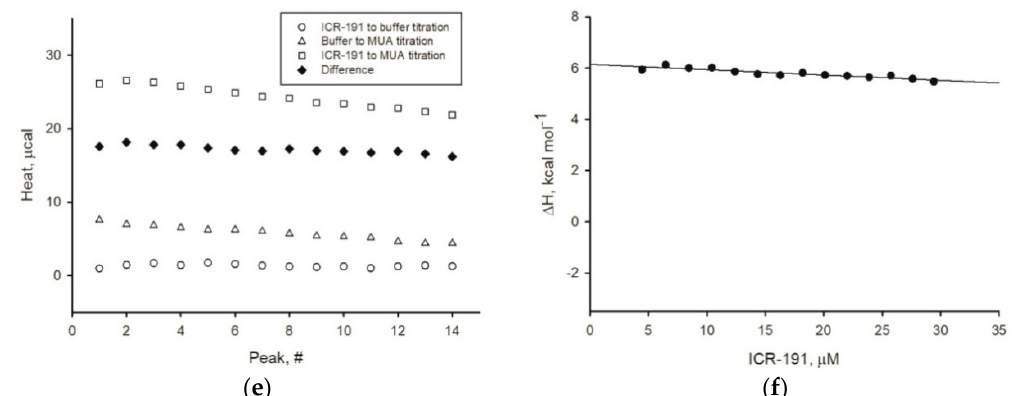
Figure 7. Thermodynamical properties of AgNPs and ICR-191 interactions. ( a ) Thermal effects of titrations of naked AgNPs with ICR-191 (squares), buffer with ICR-191 (circles), and naked AgNPs with buffer (triangles). Black diamonds represent difference between the heat of naked AgNPs titration with ICR-191 and sum of heats obtained for control titrations (buffer-ICR-191, naked AgNPs-buffer); ( b ) heat of ICR-191-naked AgNPs interactions (corrected for background thermal effects as described above), calculated as kcal mol − 1 of injected ICR-191. The enthalpy change ( Δ H) of ICR-191-naked AgNPs interactions, calculated by the linear regression (R 2 = 0.952) of experimental points to [ICR-191] tending to zero, is equal to − 2.775 ± 0.123 (±SE) kcal mol − 1 ; ( c ) thermal effects of titrations of AgNP-TBA with ICR-191 (squares), buffer with ICR-191 (circles), and AgNP-TBA with buffer (triangles). Black diamonds represent difference between the heat of AgNP-TBA titration with ICR-191 and sum of heats obtained for control titrations (buffer-ICR-191, AgNP-TBA-buffer); ( d ) heat of ICR-191-AgNP-TBA interactions (corrected for background thermal effects as described above), calculated as kcal mol − 1 of injected ICR-191. The enthalpy change ( Δ H) of ICR-191-AgNP-TBA interactions, calculated by the linear regression (R 2 = 0.918) of experimental points to [ICR-191] tending to zero, is equal to 4.547 ± 0.059 (±SE) kcal mol − 1 ; ( e ) thermal effects of titrations of AgNP-MUA with ICR-191 (squares), buffer with ICR-191 (circles), and AgNP-MUA with buffer (triangles). Black diamonds represent difference between the heat of AgNP-MUA titration with ICR-191 and sum of heats obtained for control titrations (buffer-ICR-191, AgNP-MUA-buffer); ( f ) heat of ICR-191-AgNP-MUA interactions (corrected for background thermal effects as described above), calculated as kcal mol − 1 of injected ICR-191. The enthalpy change ( Δ H) of ICR-191-AgNP-MUA interactions, calculated by the linear regression (R 2 = 0.839) of experimental points to [ICR-191] tending to zero, is equal to 6.147 ± 0.049 (±SE) kcal mol − 1 .